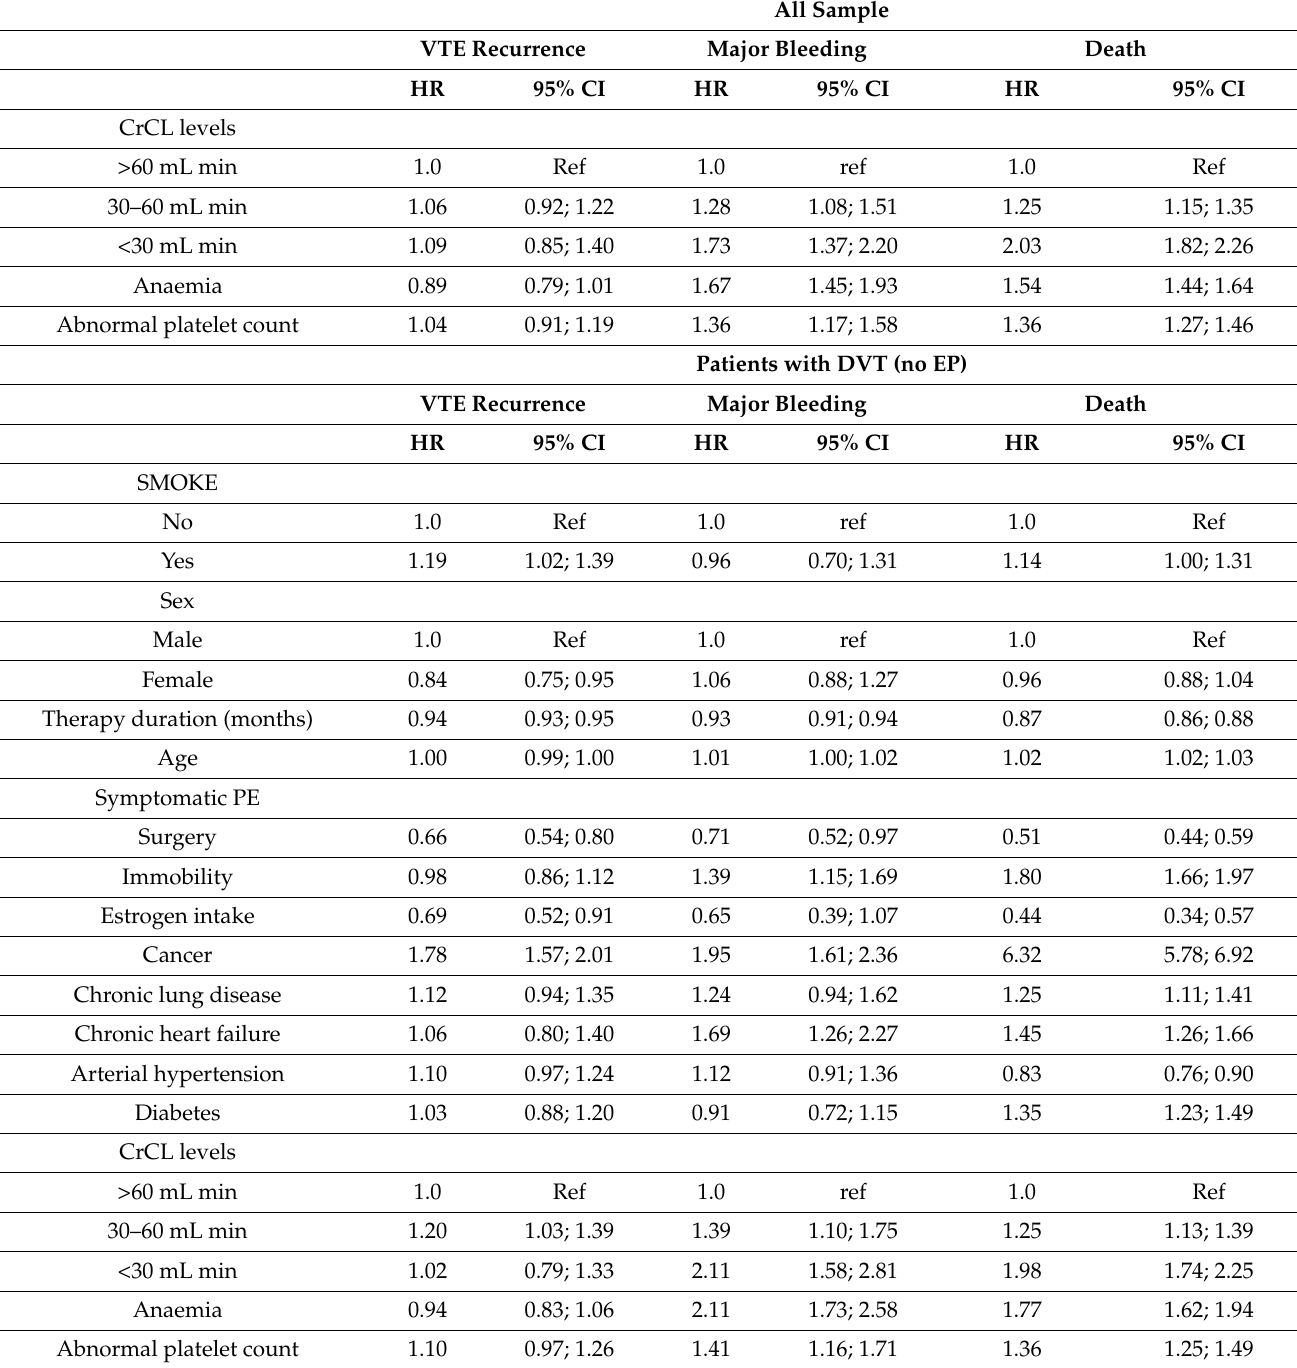
Legend to Table 4: HR, hazard ratio; CI, confidence intervals; PE, pulmonary embolism; CrCl, creatinine clearance; DVT, deep vein thrombosis; Ref.,